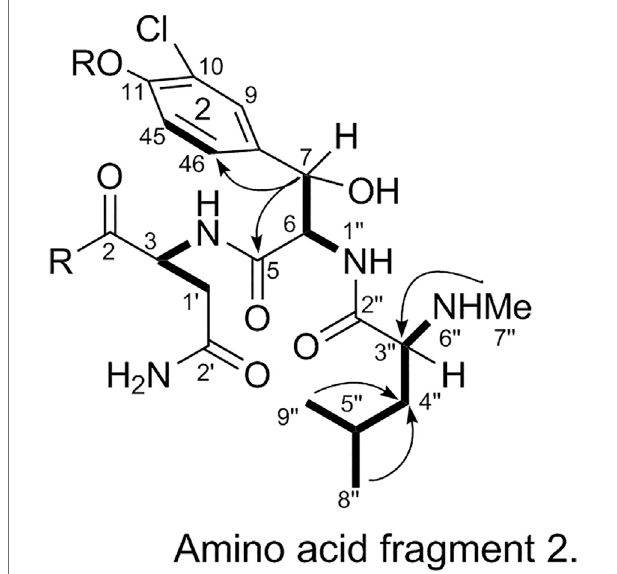
FIGURE 6 | Structure of 1 based on the NOSEY